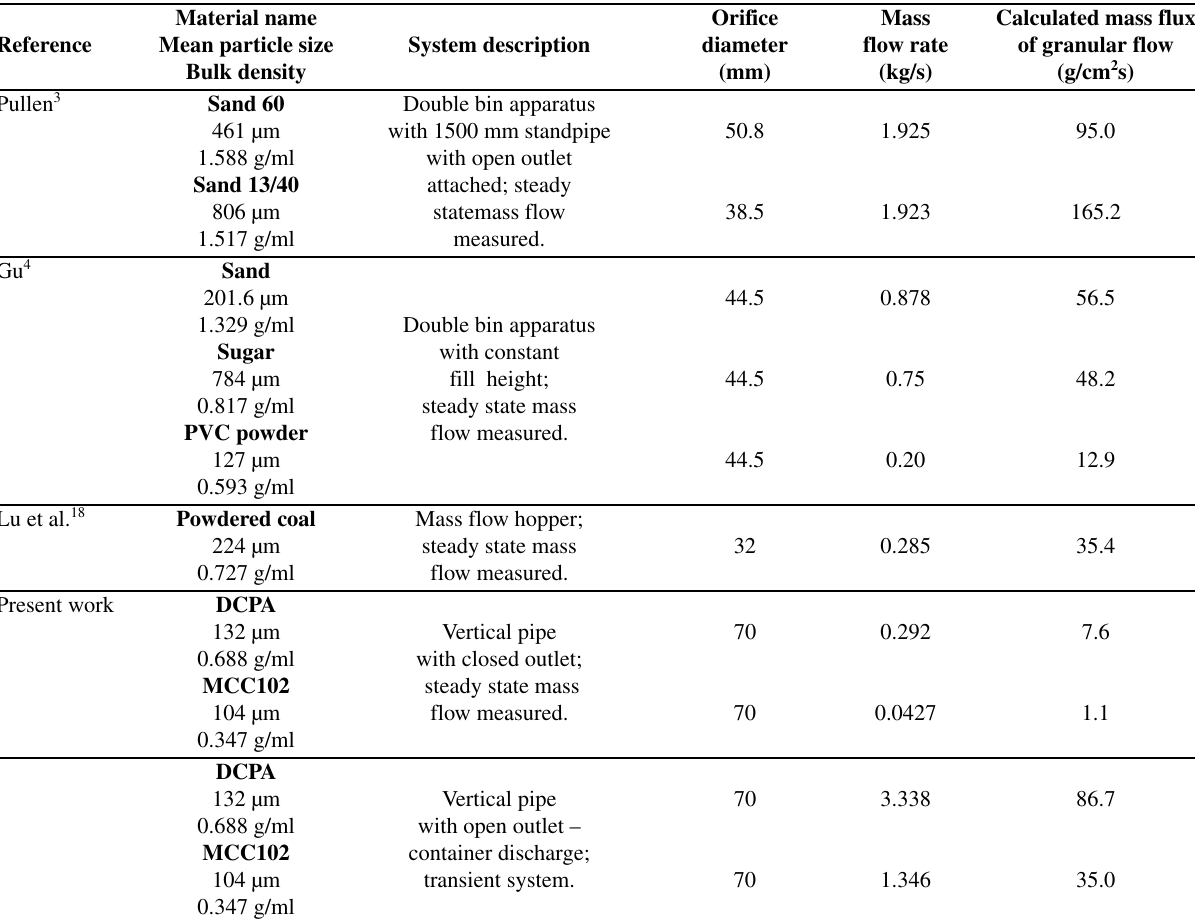
Table 6. Comparison of flow data from literature for various materials (sand, sugar, PVC powder, powdered coal) with powder mass flow rates ob- tained in present study for dicalcium phosphate anhydrous (DCPA) and microcrystalline cellulose MCC102. Short description of test material